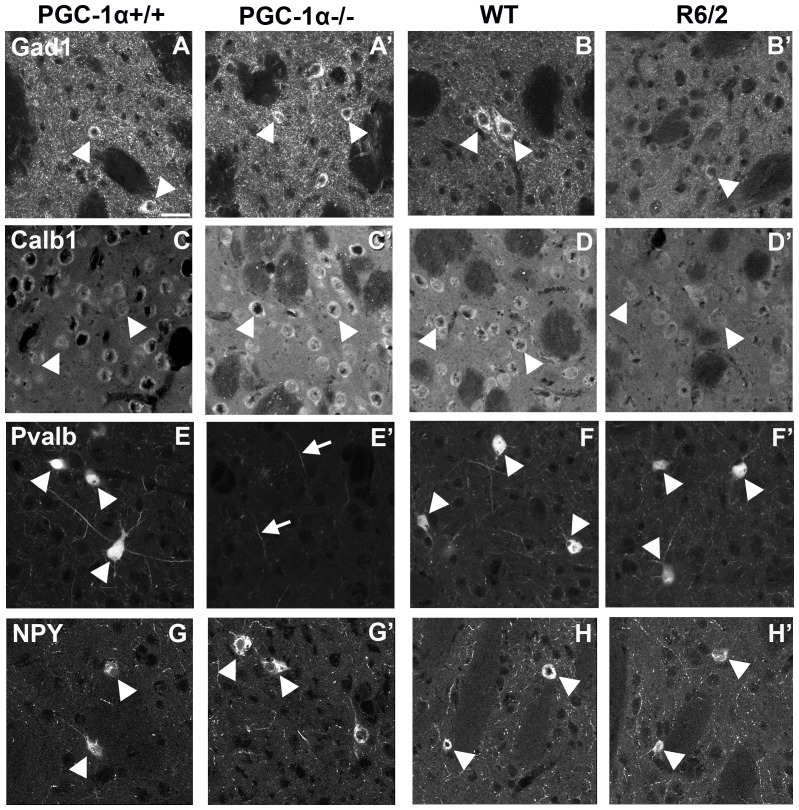
Evaluation of selected medium spiny neuron (MSN) and interneuron markers in the striatum of PGC-1α −/− and R6/2 mice.Representative confocal images of coronal sections of the striatum stained with antibodies directed against Gad1 (A–B), Calb1 (C–D), Pvalb (E–F), and NPY (G–H) demonstrate that protein expression changes closely mirror those at the transcript level in PGC-1α +/+ and −/− and R6/2 and WT littermates. PGC-1α −/− mice exhibit no change in Gad1 expression (A′, arrowheads), while Calb1 (C′) and NPY (G′) expression was increased in cell bodies (arrowheads) and processes of PGC-1α −/− mice compared to +/+ mice (A,C,G). Pvalb was minimally expressed in PGC-1α −/− cell bodies (E′); however, some staining was still evident in processes (arrows). Notably, overall MSN and interneuron number did not appear to differ between PGC-1α +/+ and −/− mice. Expression of Gad1 (B′), Calb1 (D′), and NPY (H′) were reduced in R6/2 versus WT animals (B,D,H), while expression Pvalb remained unaltered (D–D′). Decreases in Gad1 and Calb1 appeared to reflect a loss of expressing cells as well as decreased expression in remaining cells (arrows), while decreases in NPY appeared solely to reflect a loss of expression within this cellular population (arrows) in the R6/2. Scale bar = 25 µm.